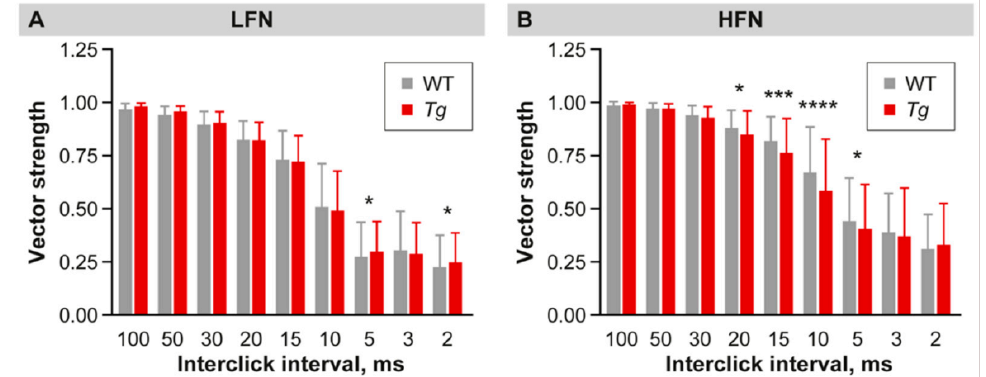
Figure 6. Precision of temporal coding. ( A , B ) Ability of LFN ( A ) and HFN ( B ) to synchronize with click trains with different inter-click intervals expressed using vector strength (VS) values. Mean ± SD, one-way ANOVA, Fisher’s LSD post-hoc test, * p < 0.05, *** <0.001, **** p <